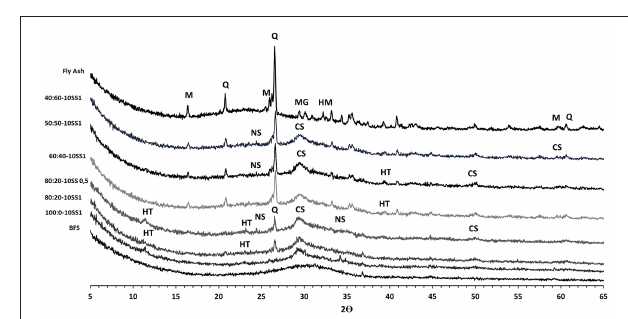
FIGURE 7 | Drying shrinkage results of concrete cylinders in laboratory environment (20 ± 2 ◦ C and 42 ± 2%RH), (A) Total measured shrinkage, (B) drying shrinkage.